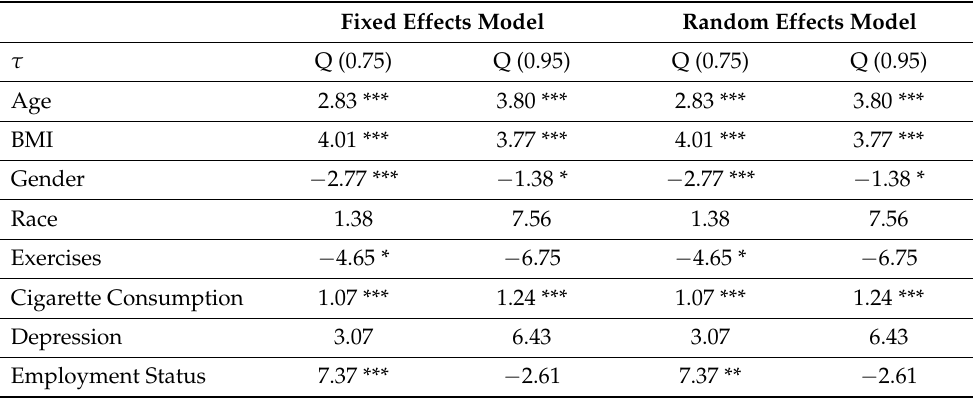
Table 6. Panel Quantile Regression Estimates for DBP’s Risk